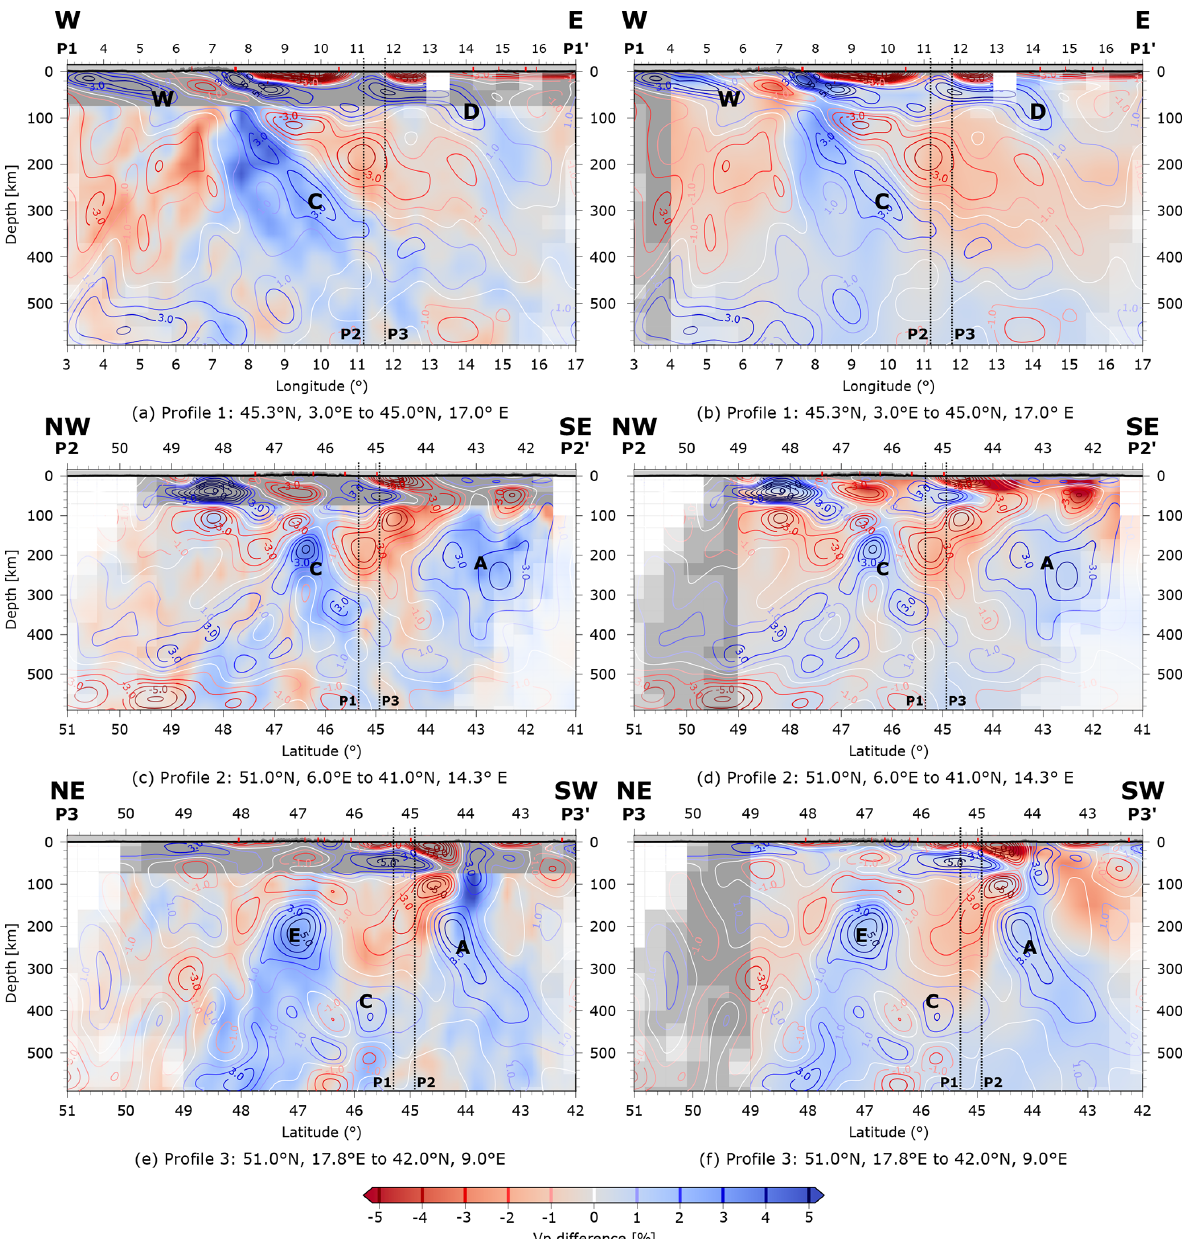
Figure 16. Comparison of the results of this study with the models of Zhao et al. (2016) (left column) and Koulakov et al. (2009) (right column). Contour lines of our model are plotted for each 1% change in P-wave velocity on top of the results of Zhao and Koulakov (shaded colours). Grey colours show areas where Zhao and Koulakov do not provide P-wave velocity